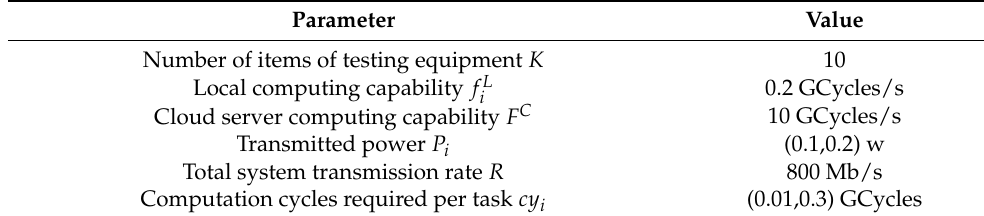
Table 2. Simulation